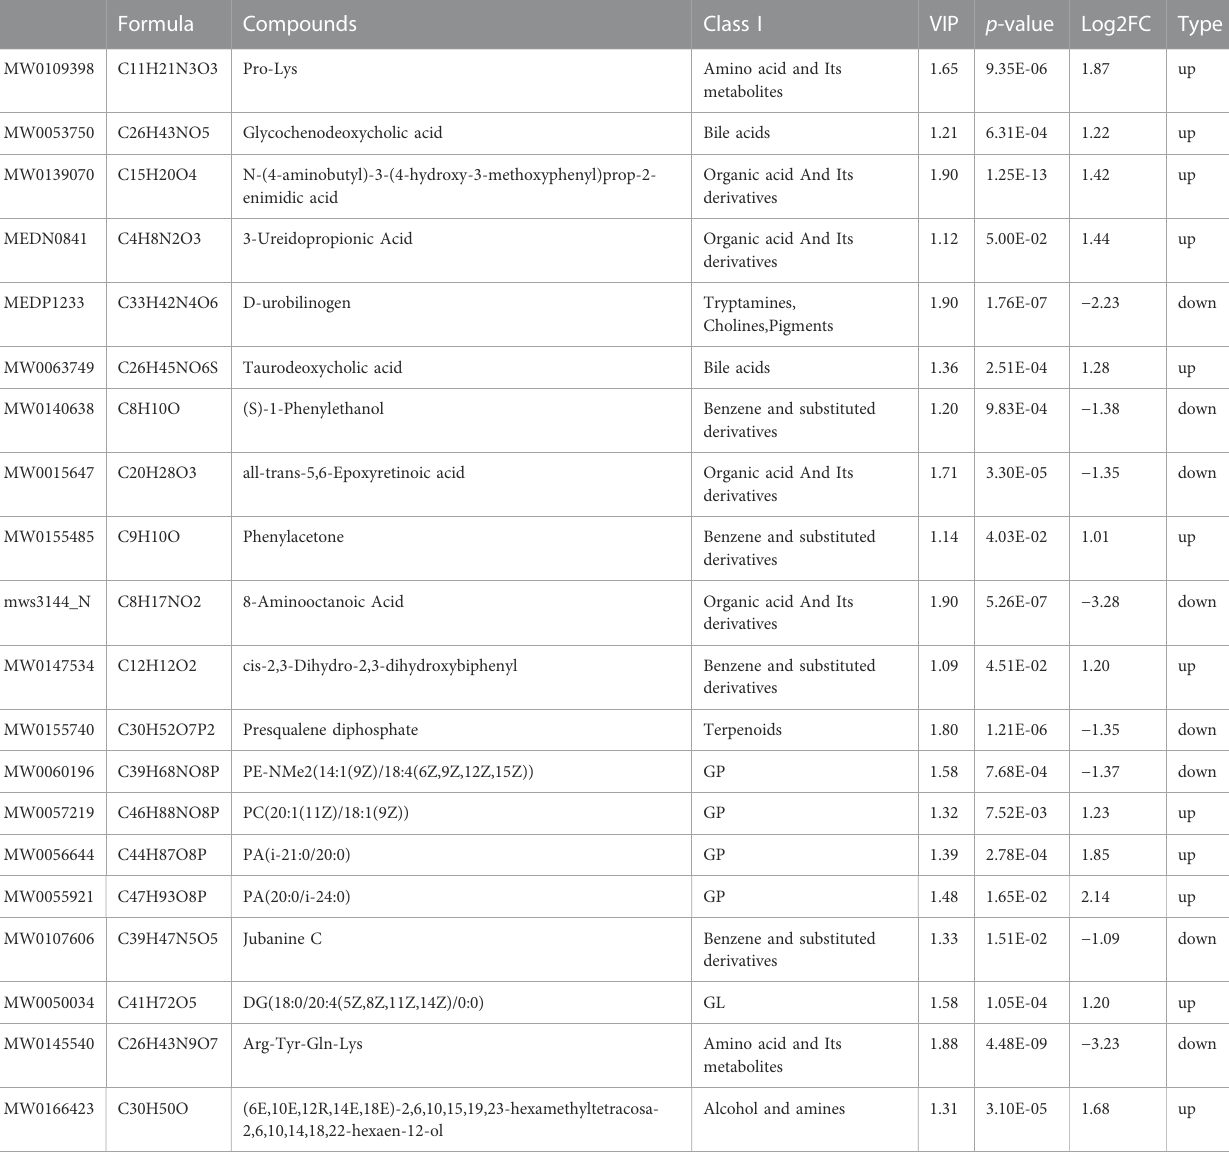
TABLE 1 Levels of 41 biomarkers were signi fi cantly restored by THD treatment.